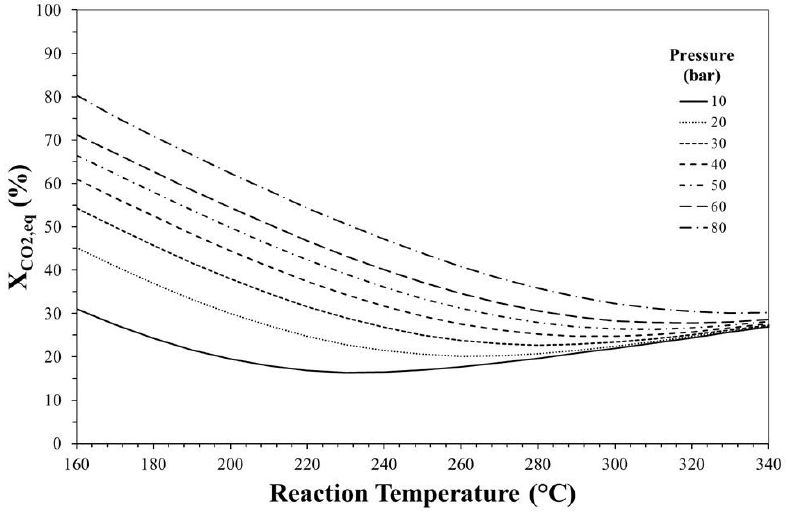
Figure 2. Effect of reaction temperature and pressure on CO 2 equilibrium conversion. H 2 /CO 2 (mol/mol) = 3.